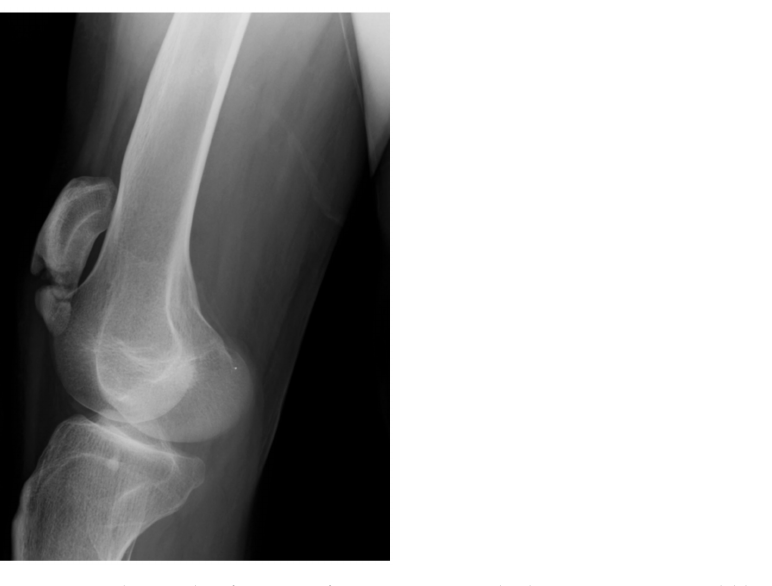
Figure 6. Radiographic features of Stage 4 MSP in the knee, in a 16-year old boy with severe crouch gait. There is marked patella alta and stress fracture of the patella with signs of healing with separation at the fracture site.